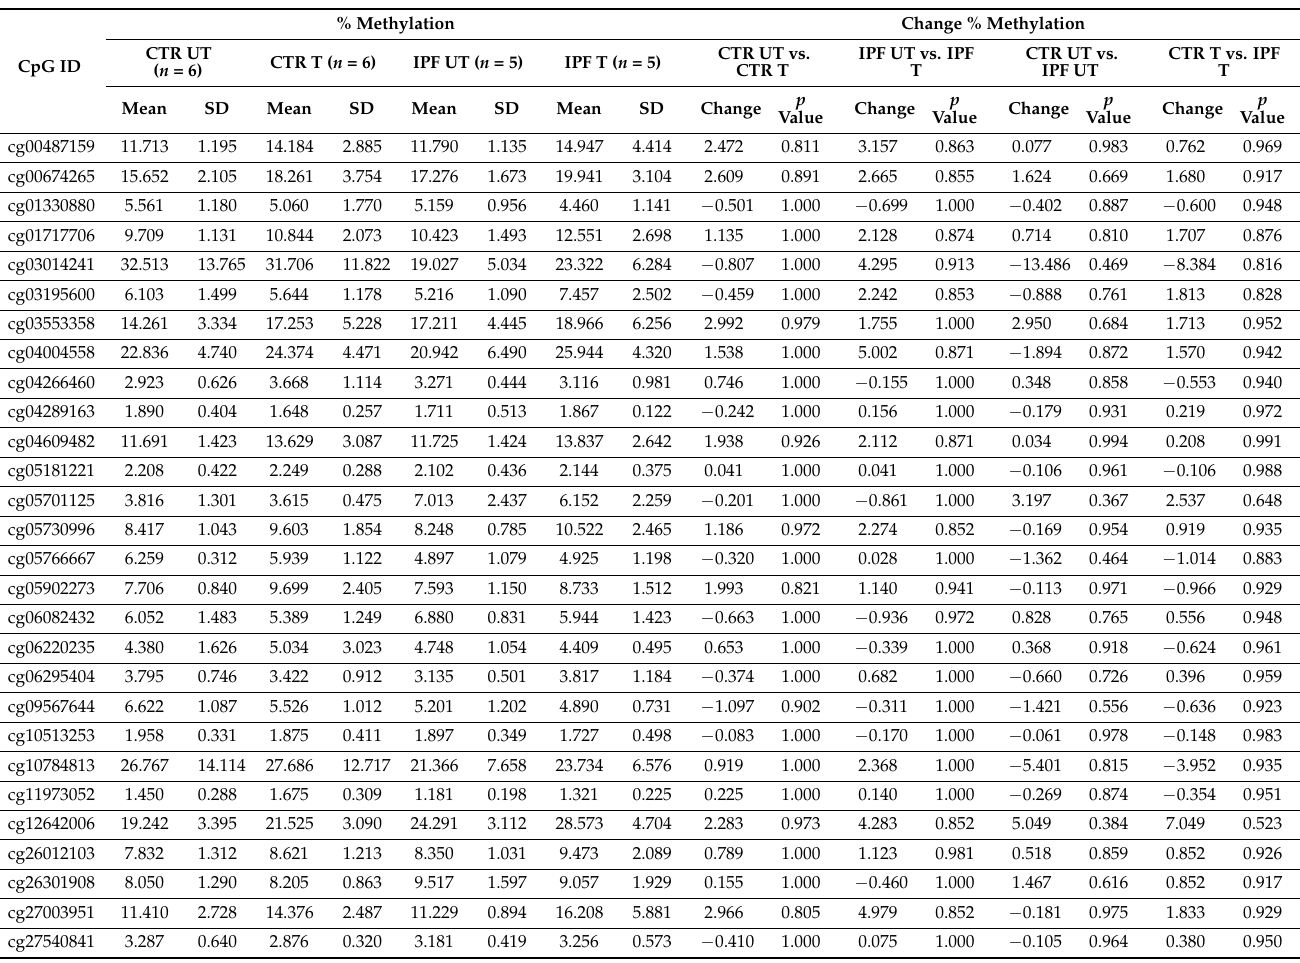
Table 2. Methylation analysis of the SOCS1 gene was performed on six control lung fibroblast cultures and five IPF lung fibroblast cultures using the Illumina Infinium Human Methylation 450 BeadChip microarray. Both basal levels of methylation (untreated (UT)) and the level of methylation in 5 (cid:48) -aza-2 (cid:48) -deoxycytidine (5 (cid:48) aza)-treated (T) cells were measured. Cell cultures were treated daily with 1 µ M of 5 (cid:48) -aza for more than a week to ensure at least three population doublings as previously described [22]. For microarray data, an adjusted P value of 0.05 and a ∆ β value ≥ 0.136 was considered significant [25–31]. Data are represented as % methylation at a given CpG site within the SOCS1 gene. No significant change in the level of methylation was detected at any of the sites tested or in the four comparisons tested; CTR UT vs. CTR T,